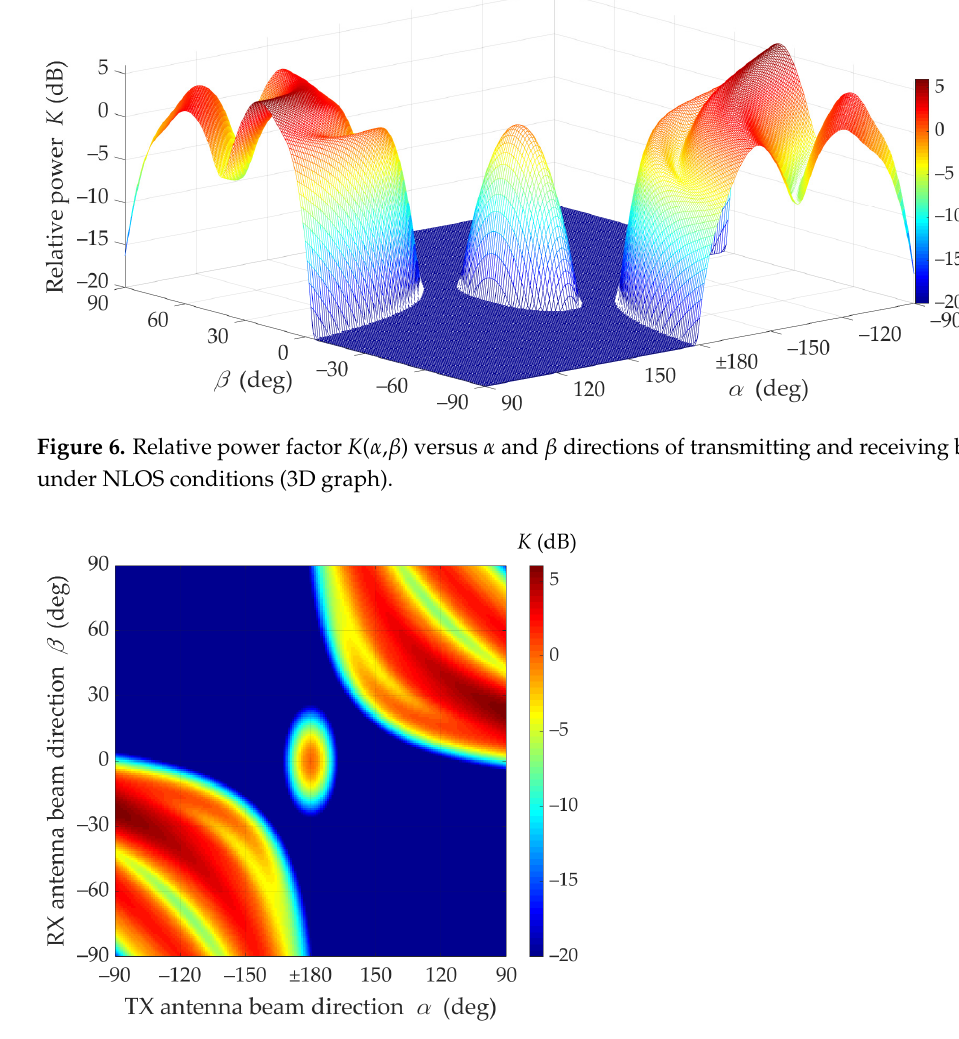
Figure 7. Relative power factor K ( α , β ) versus α and β directions of transmitting and receiving beams under NLOS conditions (2D graph).